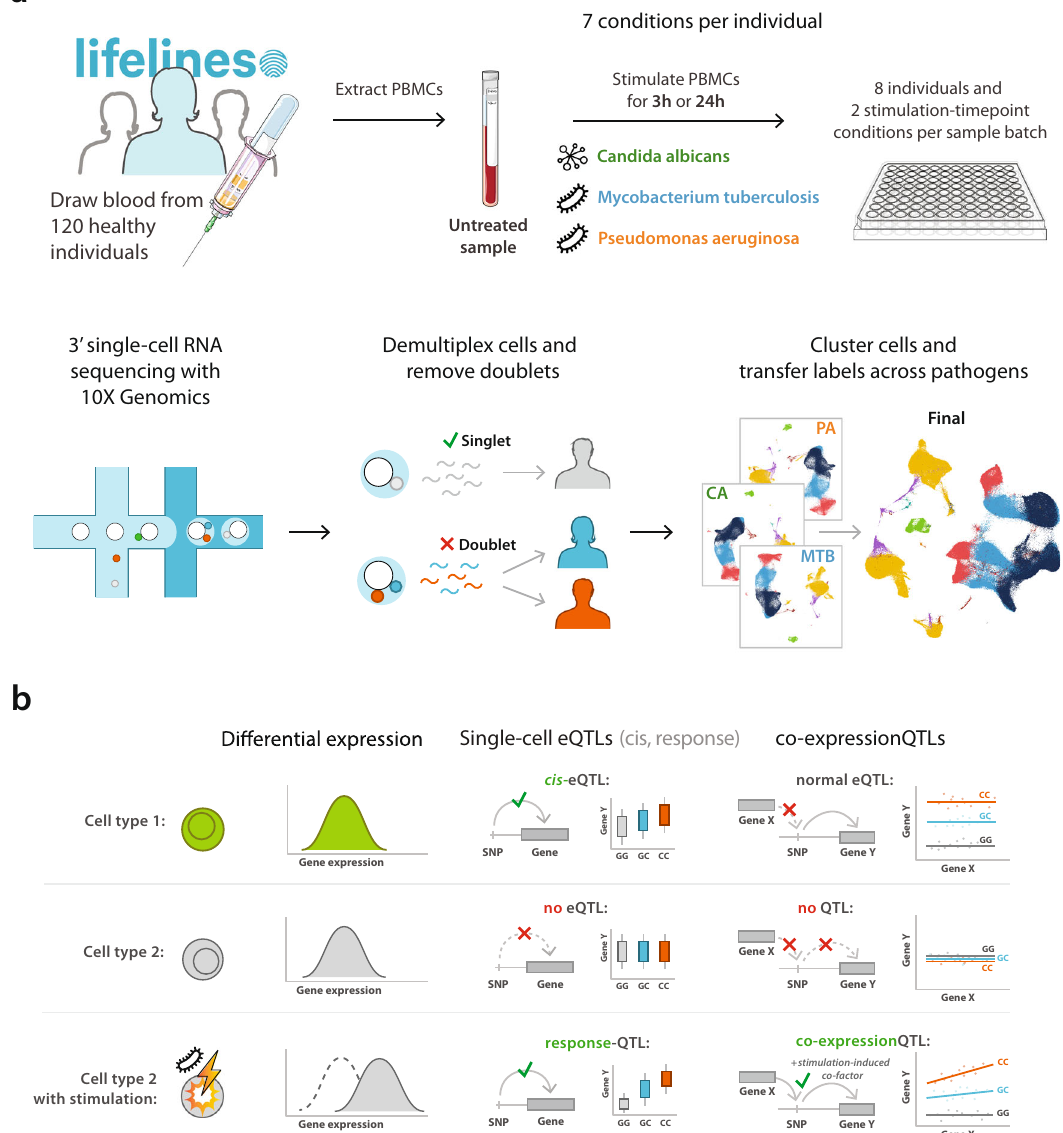
Fig. 1 Study overview. a Blood was drawn from 120 individuals from the Northern Netherlands participating in the population-based cohort Lifelines. PBMCs were isolated within 2 h of blood collection and cryopreserved in liquid nitrogen until further use. For each scRNA-seq experiment, PBMCs from 16 individuals were thawed. Per individual, these PBMCs were left untreated (UT) or were stimulated with C. aAlbicans (CA), M. tTuberculosis (MTB), or P. aAeruginosa (PA) for 3 h or 24 h in a 96-well plate. In total, this resulted in 7 stimulation ‒ timepoint combinations per 120 individuals = 840 different conditions processed. Multiplexed 3 ’ -end scRNA-seq was performed using the v2 and v3 chemistries of the 10x Genomics platform. Per experiment, two sample batches of a 10x chip were loaded, each containing a mixture of eight individuals and a combination of two different stimulation ‒ timepoint combinations. After sequencing, samples were demultiplexed and doublets were identi fi ed. Cell-type classi fi cation was performed on the QCed dataset by clustering the cells per pathogen, mixed with cells of the unstimulated condition. The cell-type labels were subsequently transferred back to the dataset containing all cells. b This study was conducted to identify cell-type-speci fi c or pathogen-stimulation-dependent: (1) differentially expressed genes, (2) eQTLs and response-QTLs, and (3) co-expression than to the type of pathogen. Consequently, the genetic control of these responsive genes is expected to be more time-dependent (Fig. 2c, Supplementary Fig. 1f): 39.8% of the total unique DE than pathogen-dependent. genes were shared across the same timepoint (7.4% at 3 h and To evaluate the DE results and con fi rm proper activation of the 32.4% at 24 h), whereas only 10.3% of DE genes were unique to a cells upon stimulation, we performed two different analyses. In speci fi c pathogen stimulation and 41.3% were shared across all the fi rst analysis, we measured the activity of a general stimulation ‒ timepoint combinations. This indicates that the stimulation-responsive pathway — the antigen-processing cross- immune response to our pathogen stimulations of both bacterial presentation pathway (REACTOME R-HSA-1236975) — that and fungal origin was more speci fi c to timepoint after stimulation should become activated in each of the cell types and upon each